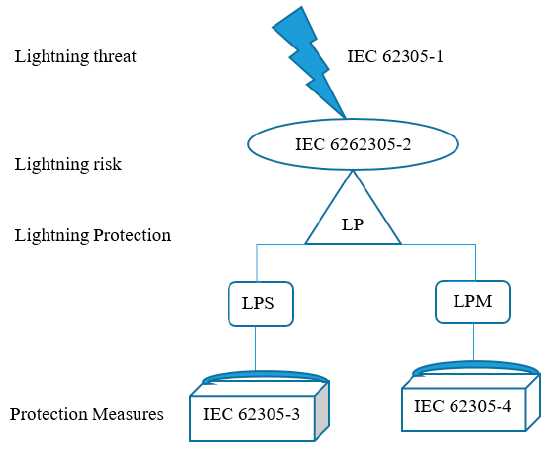
Figure 1. The introduction of IEC62305.